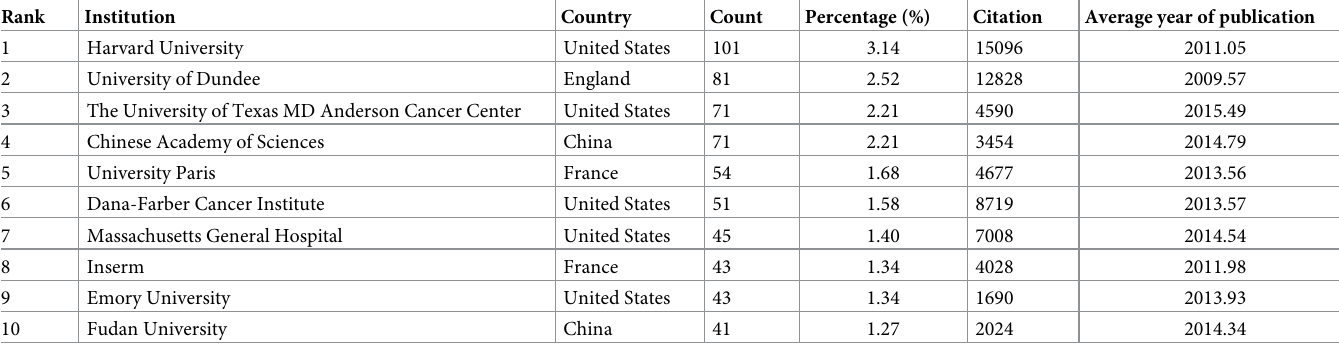
Table 2. Top 10 productive institutions in LKB1 research, 2000 to 2021.